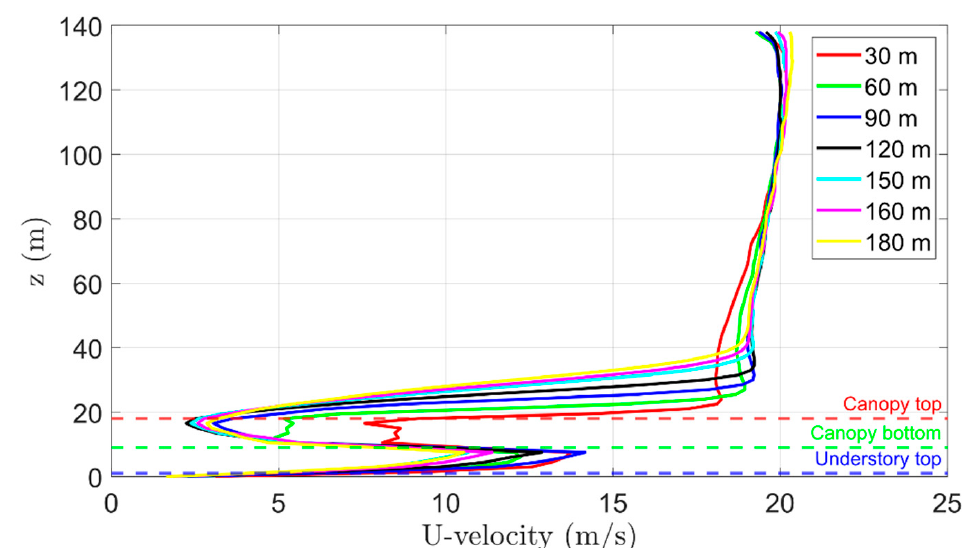
Figure 11. The developed wind field with the 750 mm grid is shown at different x locations from the